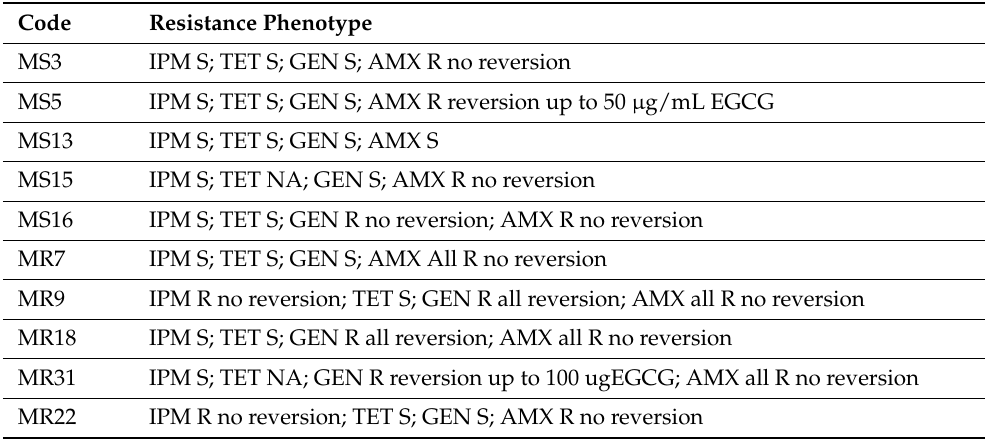
Table 2. Selected MSSA and MRSA strains for molecular profile analysis and that presented a divergent resistance phenotype. Antibiotic susceptibility was assessed using the disk